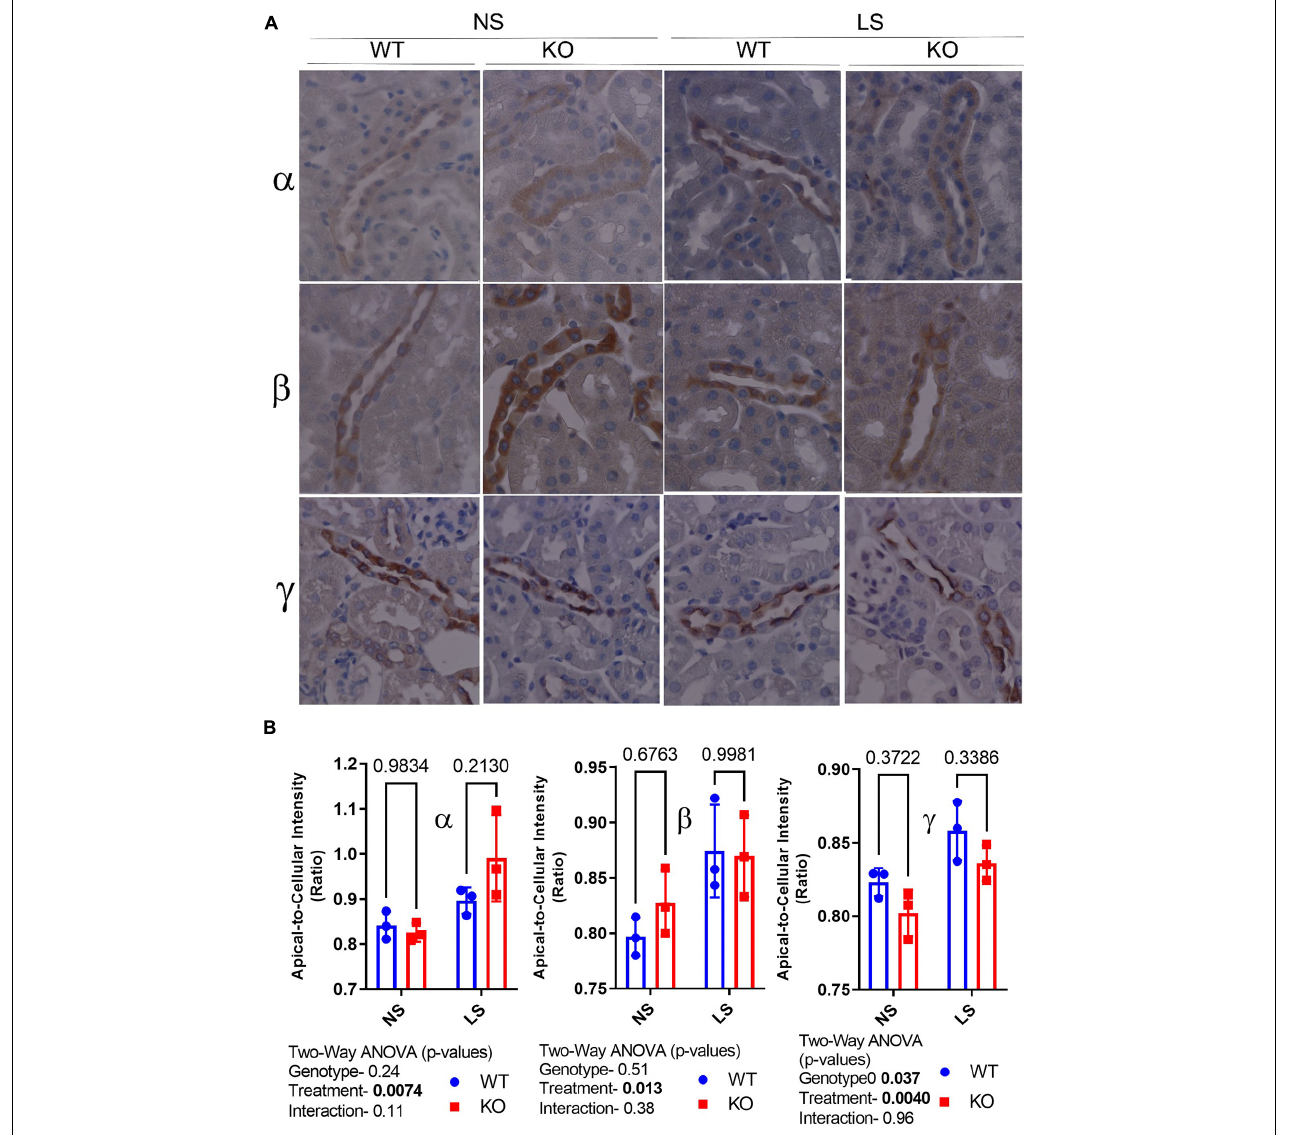
FIGURE 5 | Epithelial sodium channel (ENaC) subunit principal cell localization. (A) Immunoperoxidase-staining was used to assess intensity and sub-cellular localization of α - (top panel), β - (middle panel), and γ -(bottom panel) ENaC in 7-day NS or LS-treated male WT and KO mice. (B) Summary analysis of mean pixel intensity (Image J, NIH) in the apical-to-cellular regions of the principal cells ( n = 10 replicate cells/stained section, n = 3 mice/group). LS diet increased relative apical localization of all ENaC subunits Moreover, γ -ENaC apical staining was lower in the KO (relative to WT).